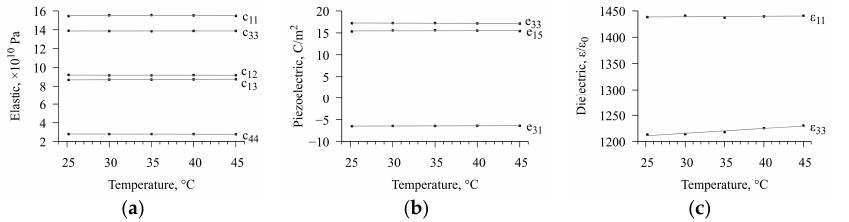
Figure 7. Dependencies of the material constants of piezoceramics on temperature. Dots are the results of fitting, and straight lines are the result of linear regression. ( a ) Elastic moduli; ( b ) piezoelectric moduli; ( c ) dielectric permittivity. Table 2. Temperature dependencies of material constants for a sample of BPZT piezoceramics.